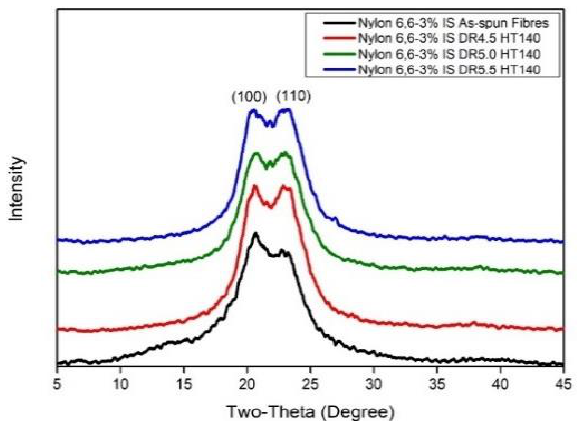
Figure 5. XRD pattern of 3% salt-confined as-spun and drawn nylon 6,6 fibres at drawing temperature of 140 ° C.